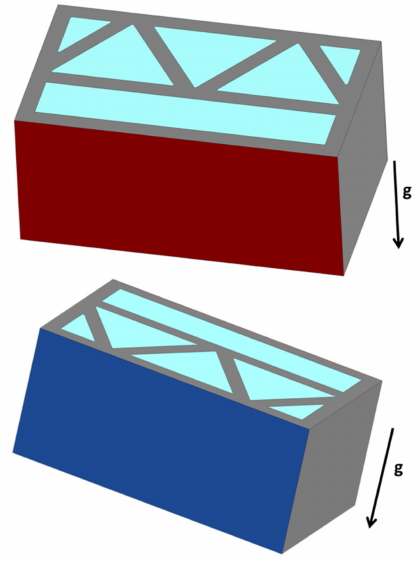
Figure 6. Boundary conditions by colors and gravity